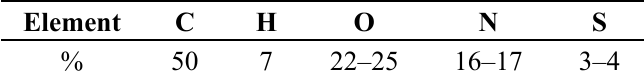
Table 1. Typical wool average chemical